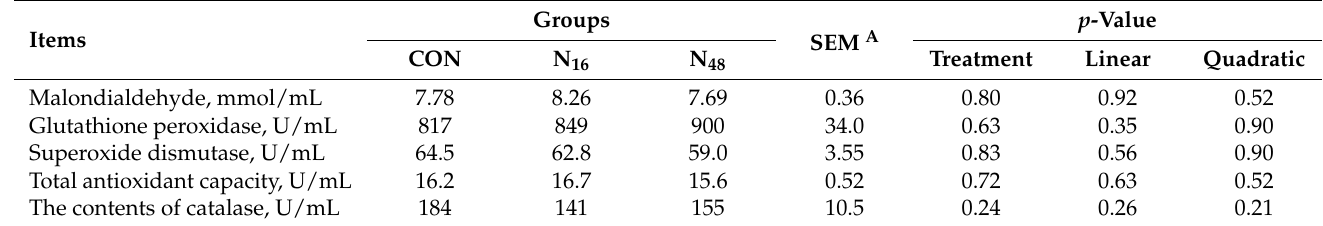
Table 3. Effects of the fruit of Nitraria tangutorum (FNT) supplement on serum antioxidant indices in Hu